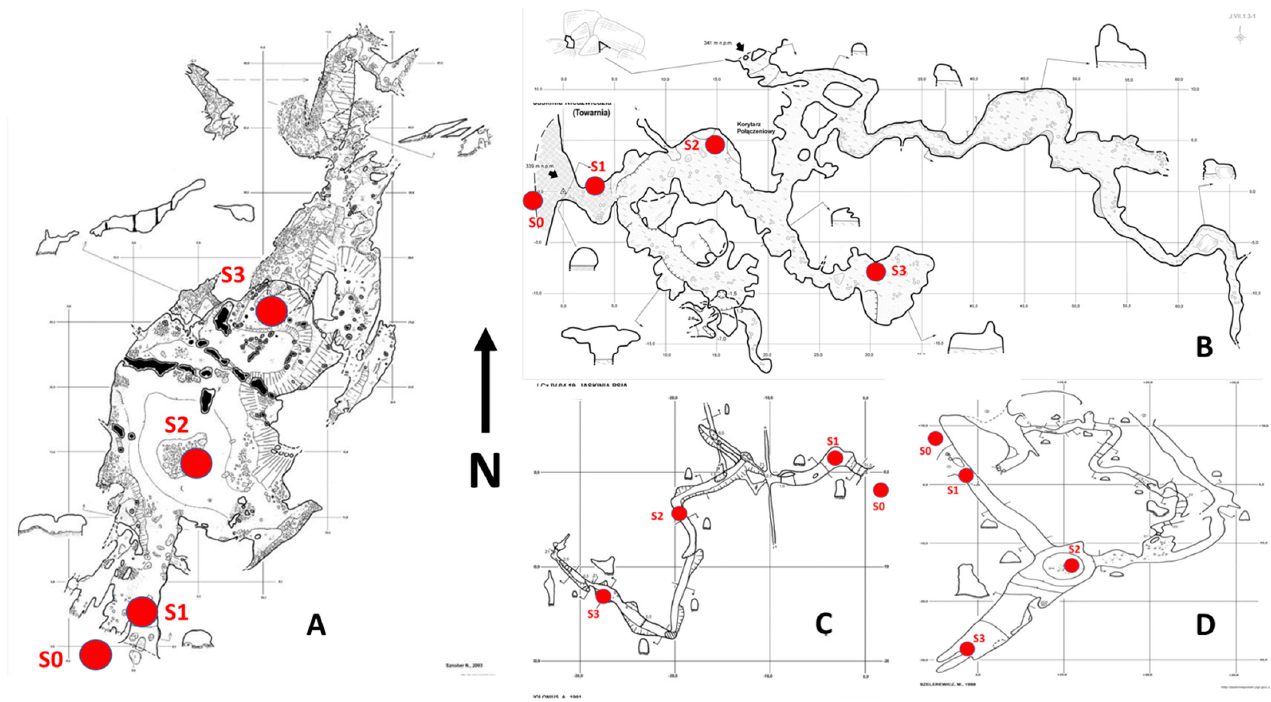
Figure 3. Diagrams of the studied caves with marked sampling points (for explanations, see the text). ( A )—W Zielonej Górze cave; ( B )—Towarna cave; ( C )—Psia cave; ( D )—Zegar cave.